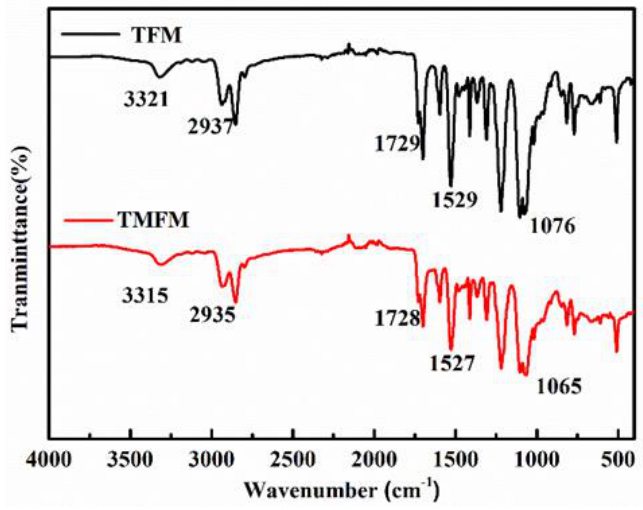
Figure 5. FTIR spectra of TFM and TMFM.